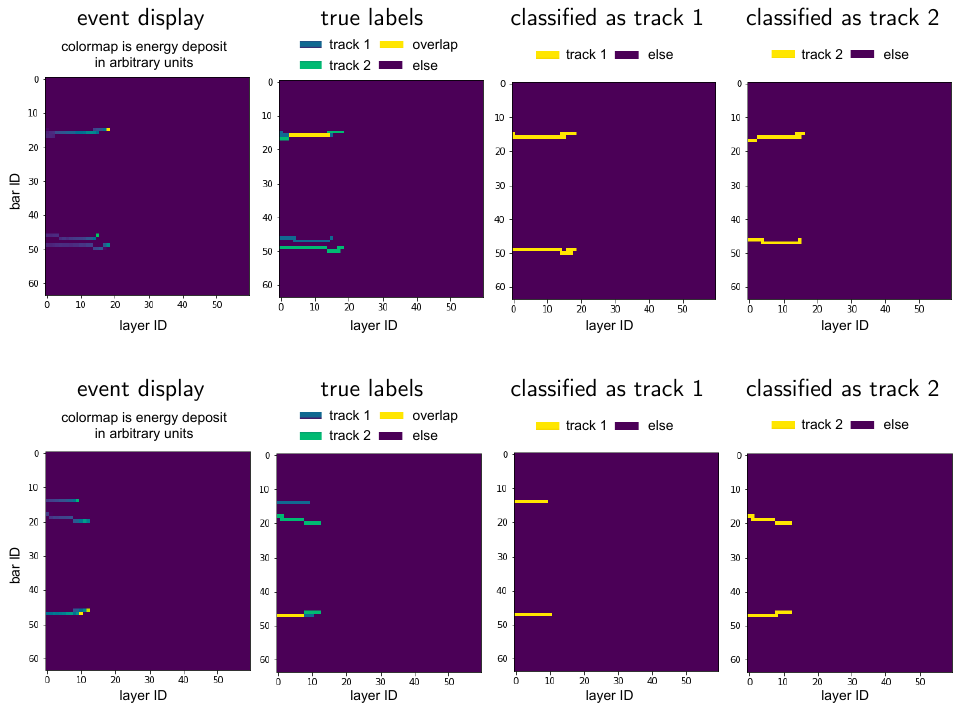
Figure 2. Examples of two events, one per row, including the input event display, the true labels and the reconstructed tracks based on the UNet output. Bar IDs 0–31 (32–63) correspond to the top (side) view of the ASTRA detector.